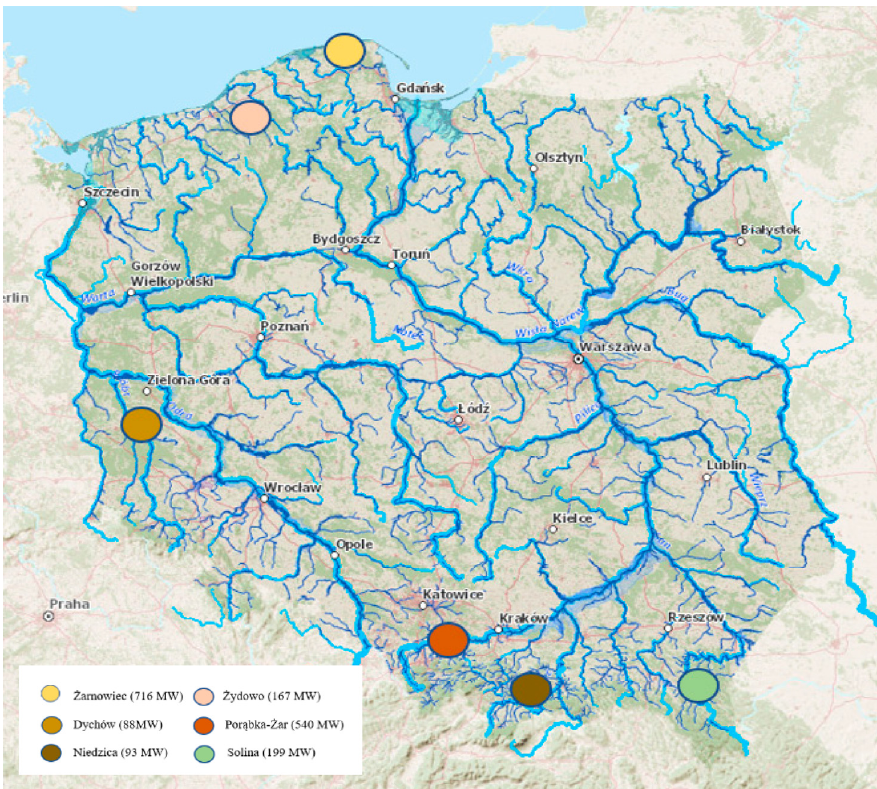
Figure 3. Location of pumped hydroelectric energy storage plants in Poland and installed capacity [36].